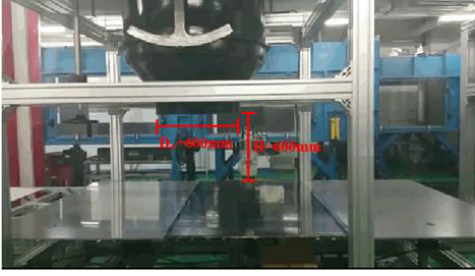
Figure 3. Illustration of the wind tunnel test.